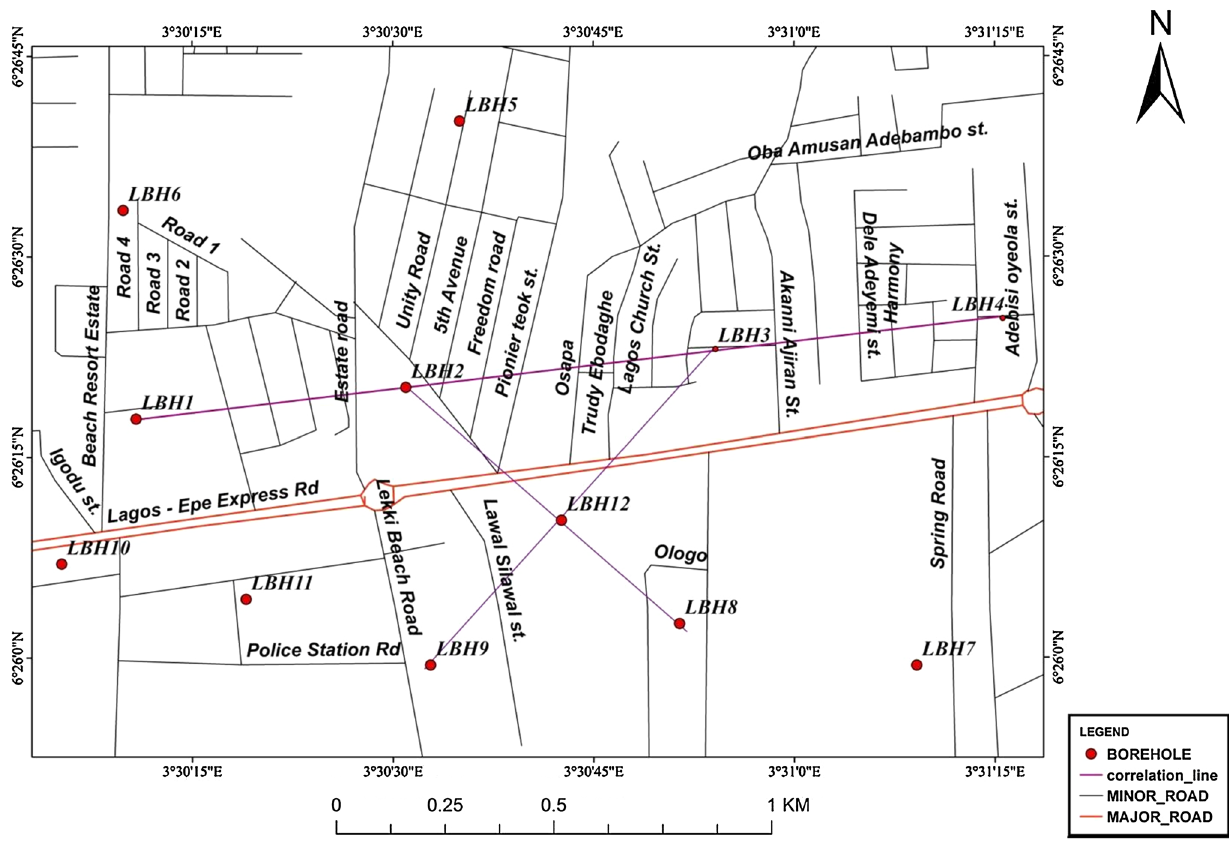
Fig. 3 Map showing borehole locations in Lekki axis